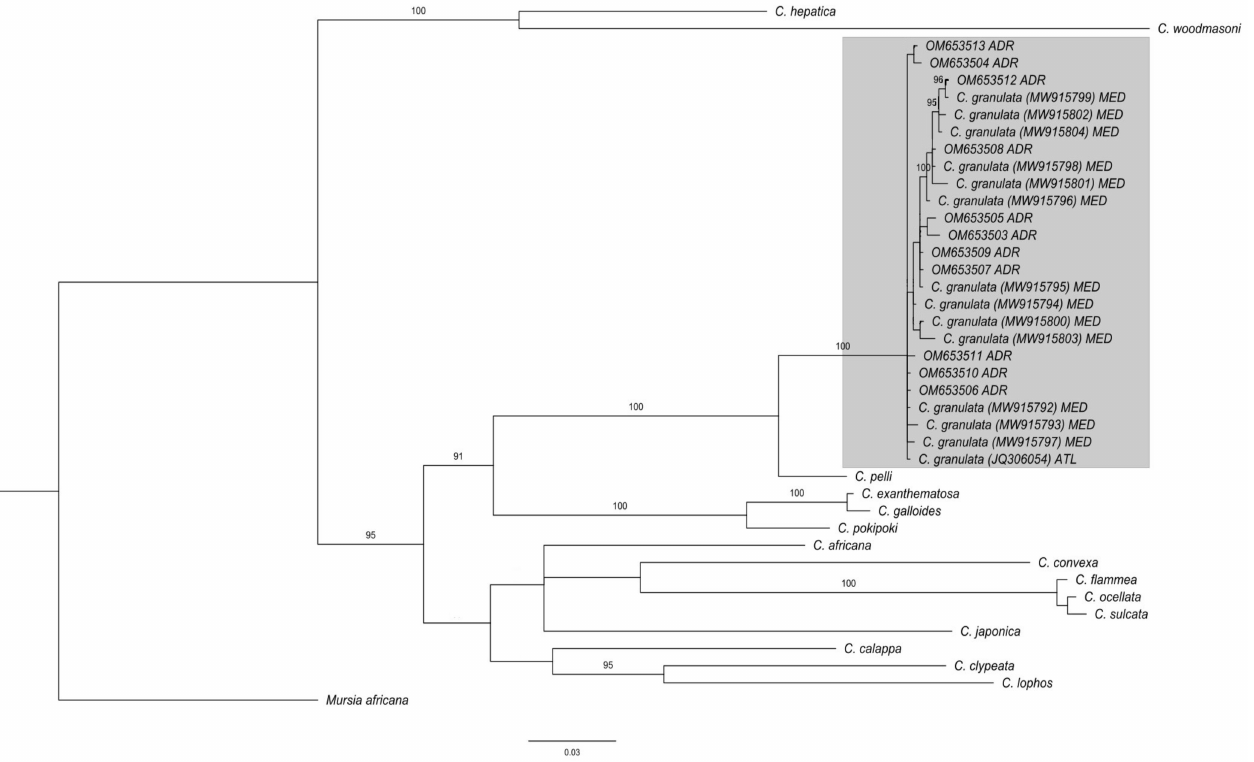
Figure 9. Bayesian phylogenetic tree based on the analysis of mtCOI sequences for the genus Calappa . BI posterior probability values above 90% are shown above the branches. Colored part distinguishes Calappagranulata clade from geographical area: ADR—Adriatic Sea, MED—Mediterranean Sea, ATL— Atlantic Ocean. GenBank accession numbers for C. granulata are shown after the species name. Mursia africana is used as outgroup. Scale bar indicates number of nucleotide substitutions per